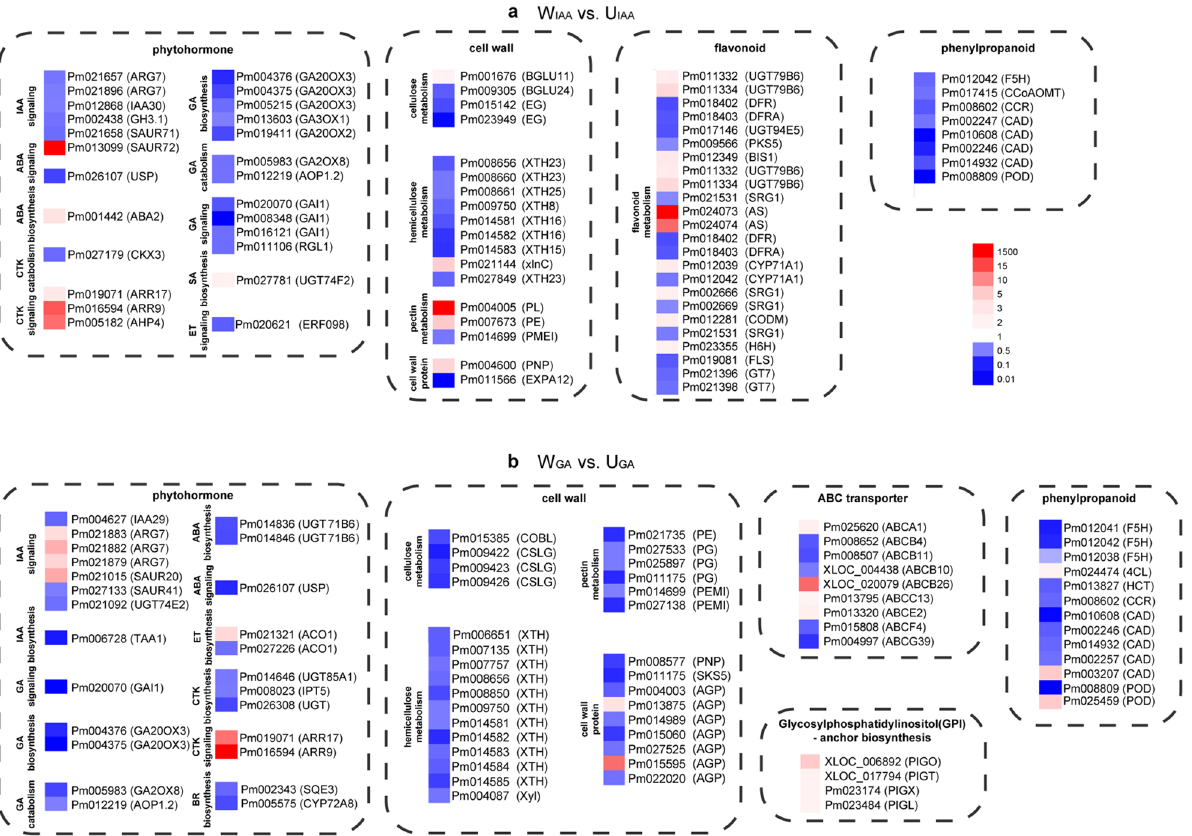
Figure 6. Clustering of DEGs in several pathways enriched in W IAA vs. U IAA and W GA vs. U GA . ( a ) DEGs involved in phytohormones, cell wall, flavonoid, and phenylpropanoid metabolism in W IAA vs. U IAA . ( b ) DEGs involved in phytohormones, cell wall, ABC transporter, Glycosylphophatidylinositol (GPI)—anchor, phenylpropanoid metabolism in W GA vs. U GA . Red and blue indicate up- and down-regulated genes, respectively (fold change). ARG , indole-3-acetic acid-induced protein ; GH3.1 , indole-3-acetic acid-amido synthetase ; SAUR , auxin-responsive protein ; UGT74E2 , uridine diphosphate glycosyltransferase 74E2 ; TAA1, L-trytophan-pyruvate aminotransferase ; GA20OX3 , gibberellin 20 oxidase 2 ; GA3OX1 , gibberellin 3 oxidase 1 ; GA2OX8 , gibberellin 2-beta-dioxygenase 8; AOP1 , inactive 2-oxoglutarate-dependent dioxygenase AOP2 ; GAI , gibberellic acid insensitive; RGL , RGA (repressor of GA)-like ; USP, universal stress protein: ABA2 , ABA deficient 2 ; UGT71B6 , UDP-glucosyl transferase 71B6 ; CKX3 , cytokinin oxidase 3 ; UGT85A1 , uridine diphosphate glycosyltransferase 85A1 ; UGT , UDP-glucosyl transferase ; IPT5 , adenylate isopentenyltransferase 5 ; ARR , response regulator ; AHP : histidine-containing phosphotransfer 4 ; UGT74F2 , UDP-glucosyltransferase F2 ; ERF098 , ethylene-responsive transcription factor 098 ; ACO1 , ACC oxidase 1 ; SQE3 , squalene epoxidase 3 ; CYP72A8 , cytochrome P450 , family 72 , subfamily A , polypeptide 8 ; BGLU , β-glucosidase ; EG , cellulose synthase-like ; COBL , COBRA-like protein ; CSLG , cellulose synthase-like G ; XTH , xyloglucan endotransglucosylase ; Xln , endo-1,4-beta-xylanase ; Xyl , beta- xylosidase ; PL , pectate lyase ; PE , pectinesterase ; PG , polygalacturonase ; PMEI , pectinesterase inhibitor ; PNP , plant natriuretic peptide ; EXP , expansin ; AGP , arabinogalactan protein ; ERG , glycine-rich cell wall structural protein ; SKS , SKU5 similar 5 ; UGT79B6 , UDP-glycosyltransferase 79B6-like ; DFR , dihydroflavonol-4-reductase-like ; DFRA , anthocyanidin reductase-like ; UGT94E5 , beta-D-glucosyl crocetin beta-1,6-glucosyltransferase-like ; PKS5 , polyketide synthase 5-like ; BIS1 , 3,5-dihydroxybiphenyl synthase-like ; SRG1 , protein DMR6-LIKE OXYGENASE 2-like ; AS , hydroquinone glucosyltransferase-like ; CYP71A1 , cytochrome P450 CYP736A12-like ; SRG1 , senescence- related gene 1 ; CODM , codeine O-demethylase-like ; H6H , protein DOWNY MILDEW RESISTANCE 6-like ; FLS , flavonol synthase/flavanone 3-hydroxylase-like ; GT7 , UDP-glucose flavonoid 3-O-glucosyltransferase 7-like ; F5H , ferulate 5-hydroxylase ; CCoAOMT , Caffeoyl-CoA O-methytransferase ; CCR , Cinnamoyl CoA reductase ; CAD , cinnamyl alcohol dehydrogenase ; POD , peroxidase ; 4CL , 4 coumarate CoA ligase ; HCT , hydroxycinnamoyl transferase ; ABC : ATP Binding Cassette transporter ; PIG , phosphatidylinositol-glycan biosynthesis protein . Red and blue indicate up- and down-regulated genes, respectively (fold